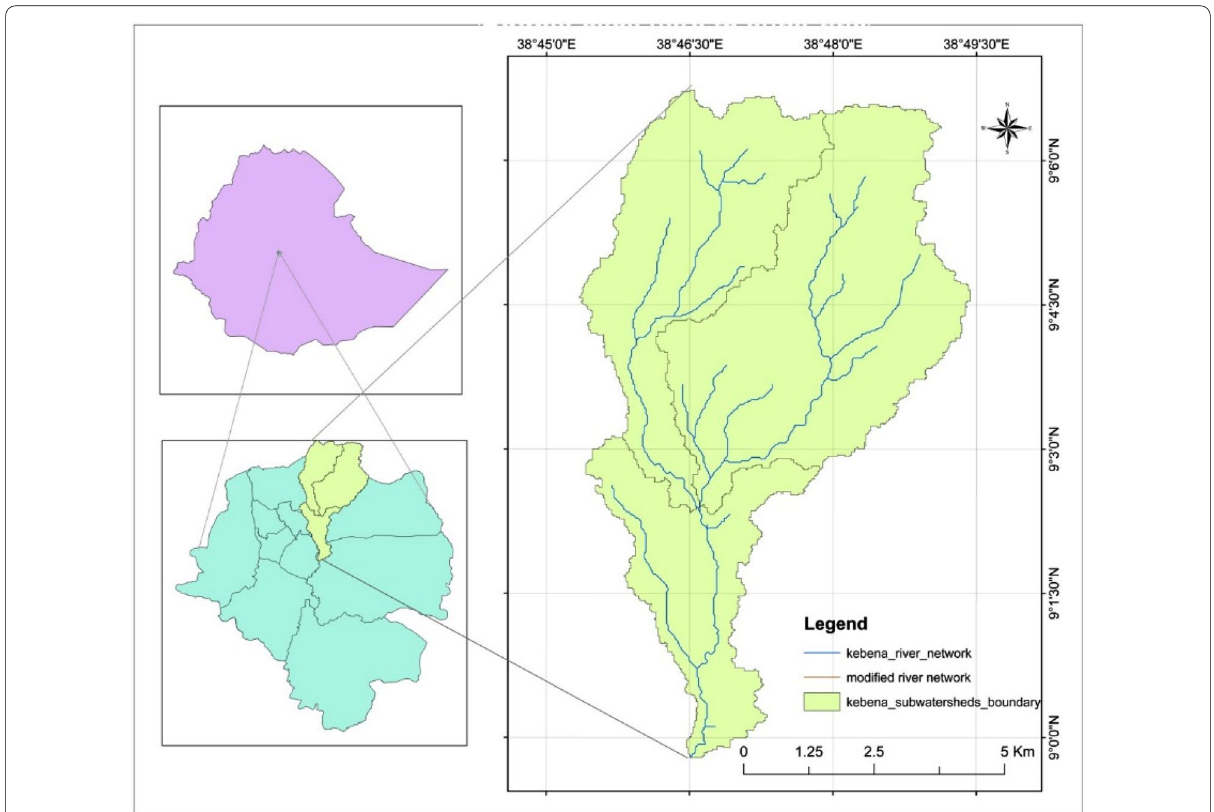
Fig. 1 Location Map of the Kebena watershed in Addis